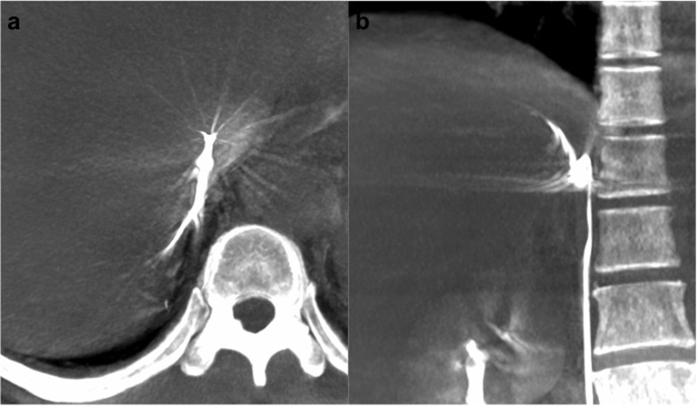
A 48-year-old woman with primary aldosteronism and a right adrenal nodule.The right inferior phrenic vein was shown on Dyna computed tomography maximum intensity projection imaging in the transverse plane (a) and coronal plane (b).